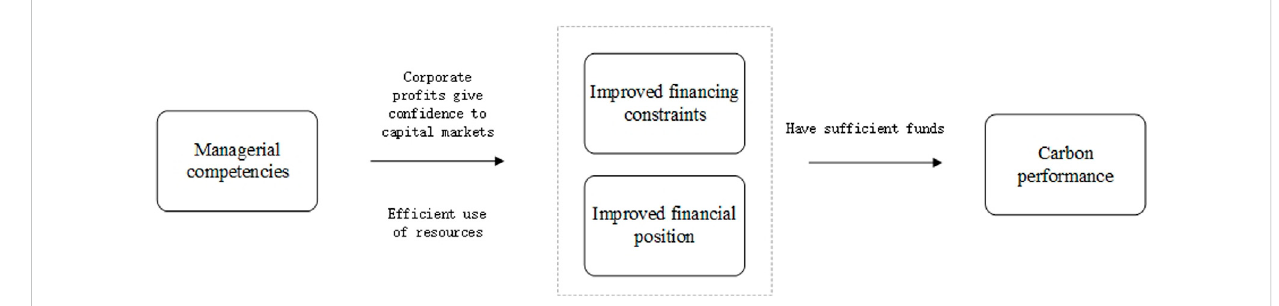
FIGURE 1 Mechanism conduction